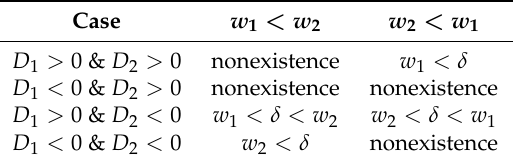
Table 3. Existence condition of E + when r 1 < r 2